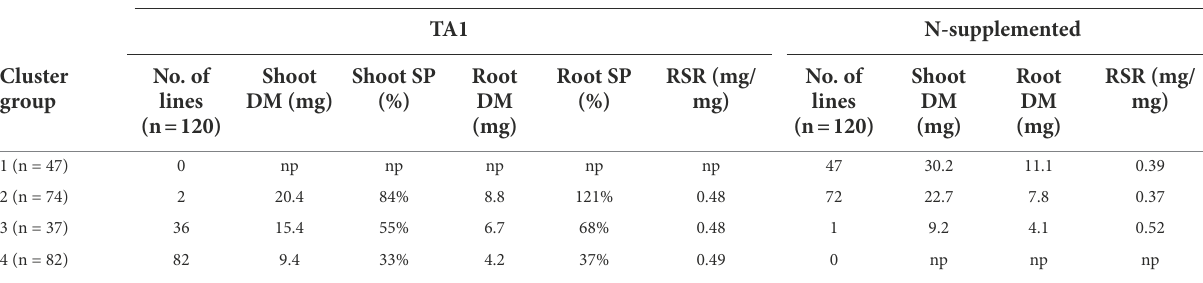
TABLE 3 Number of white clover half-sib families assigned to each of four cluster groups generated from the pattern analysis of five traits of 120 half-sib families inoculated with the Rhizobium leguminosarum bv. trifolii strain TA1 or grown with supplemental mineral nitrogen